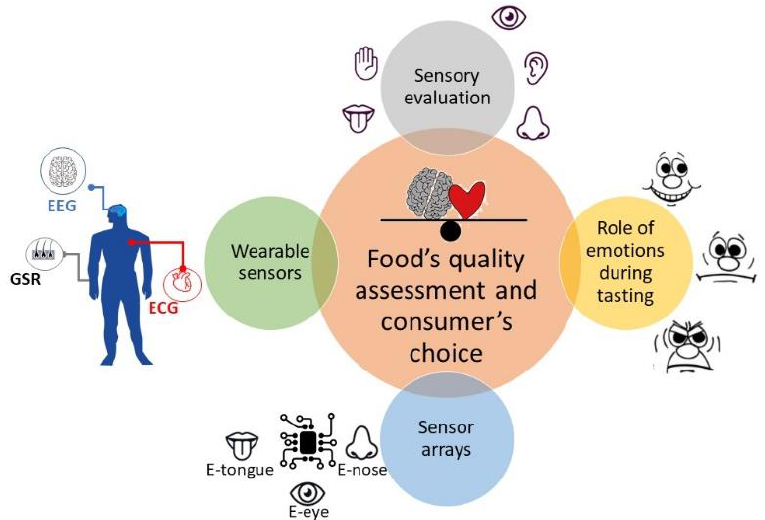
Figure 1. Summary Figure 1. Summary diagram.